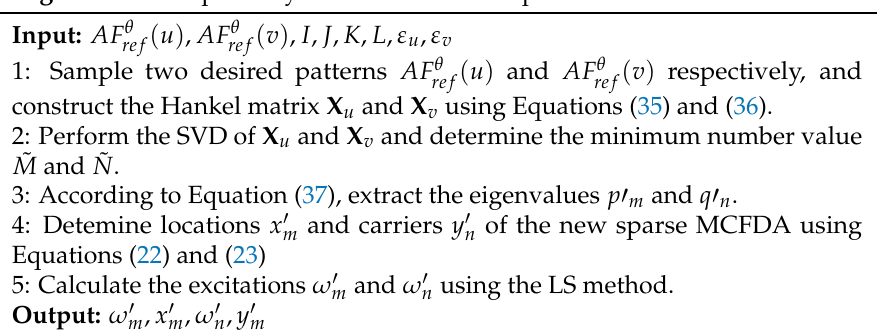
Algorithm 2: Proposed synthesis method for sparse